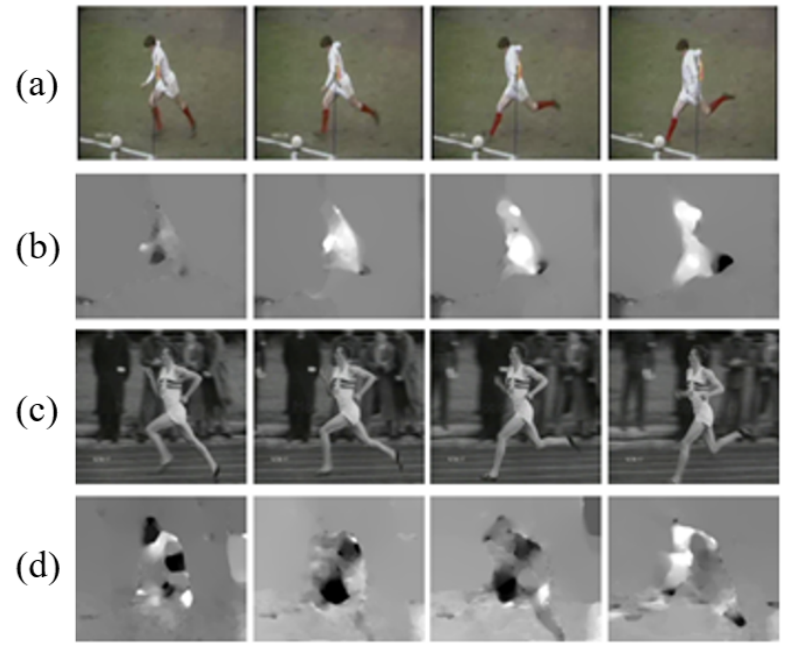
Figure 1. Examples from UCF sports [11] dataset, each row representing the image sequence of the video. ( a ) RGB images from the “Kicking” class. ( b ) Corresponding optical flow images to ( a ). ( c ) RGB images from the “Run” class. ( d ) Corresponding optical flow images to ( c